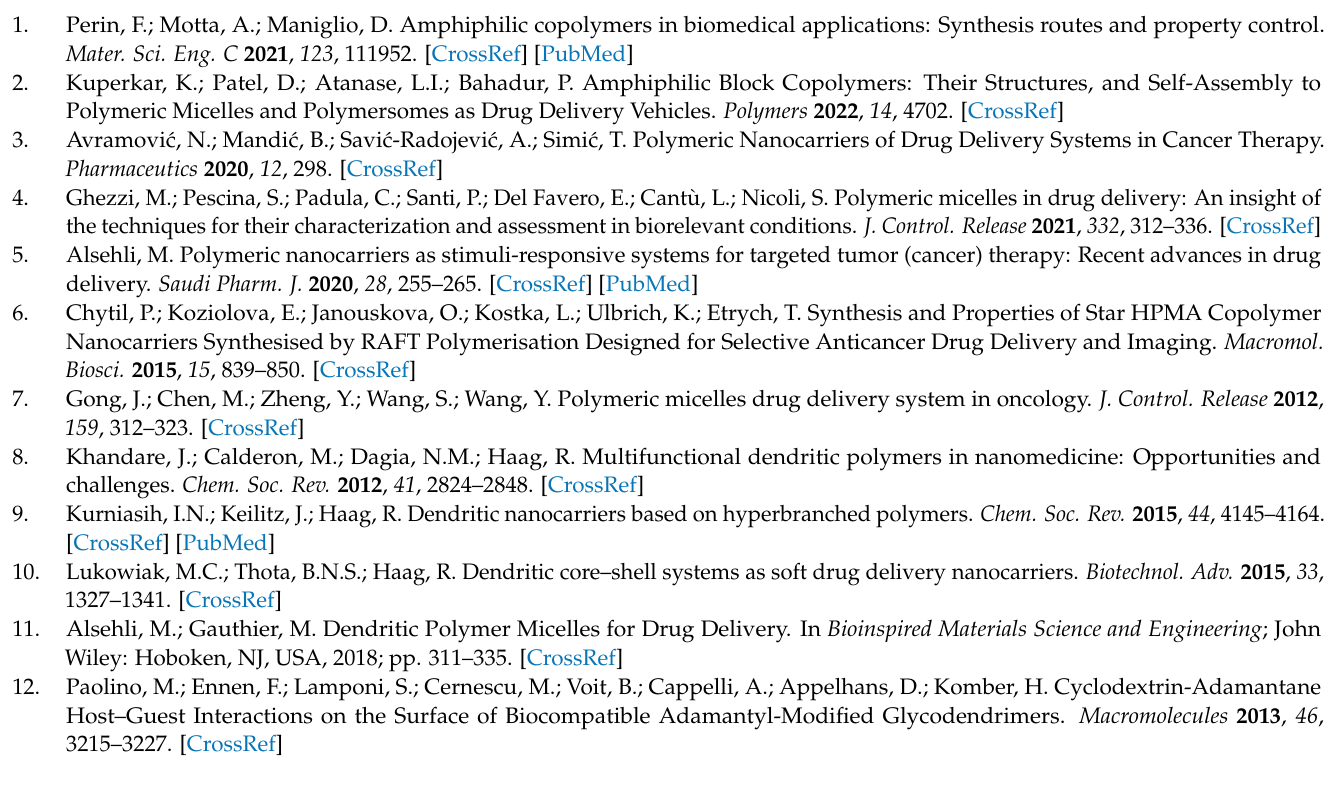
PBG substrates. Scheme S2. Polymerization of ethylene oxide with 3-aminopropanol and DPMK. Scheme S3. The reaction of 4-trifluoromethylbenzaldehyde (TFBA) with the primary amines end group in the PEO side chains. Figure S1. 1H NMR spectra for (a) fully deprotected linear PBG15, (b) partially deprotected linear PBG29, and (c) partially deprotected linear PBG65. Figure S2. SEC traces for G0 arborescent PBG samples. Figure S3. 1H NMR spectrum for α -amino PEO in CDCl3. Figure S4. 19 F NMR spectrum for linear PEO synthesized using the 3-aminopropanol/DPMK initiator system, after treatment with 4-trifluoromethylbenzaldehyde (TFBA). Figure S5. 1 H NMR spectra for G2PBG29- g -PEO in (a) D2O and (b) deuterated DMSO. Figure S6. Hydrodynamic diameter distributions for randomly grafted arborescent copolymers determined by DLS in DMF (left) and in PBS (right): (A) G2PBG 15 - g -PEO, (B) G2PBG 29 - g -PEO, and (C) G2PBG 65 - g -PEO. Figure S7. TEM (left) and AFM phase scan (right) for randomly grafted arborescent copolymers: (A) G1PBG 15 - g -PEO, (B) G1PBG 29 - g -PEO, and (C) G1PBG 65 - g -PEO. Figure S8. In vitro DOX release profiles over a 30-day period for (a) G2PBG 15 - g -PEO/DOX, (b) G2PBG 29 - g -PEO/DOX, and (c) G2PBG 65 - g -PEO/DOX in PBS (pH 7.4 and 5.5) at 37 ◦ C. Reference [41] is cited in the Supplementary